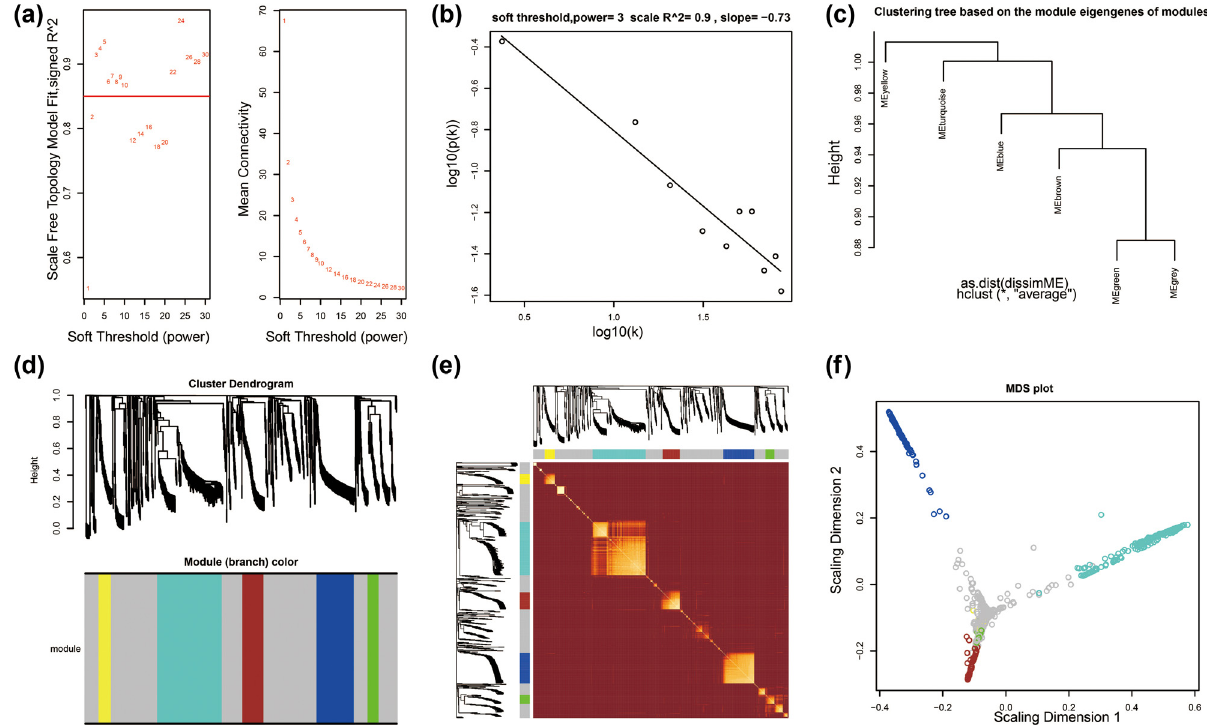
Figure 10: WGCNA analysis results of DEG: ( a ) soft thresholding; ( b ) scale - free plot; ( c ) clustering tree based on the module Eigen genes of modules; ( d ) cluster dendrogram; ( e ) topological overlap matrix ( TOM ) plot; and ( f ) multidimensional scaling plot.